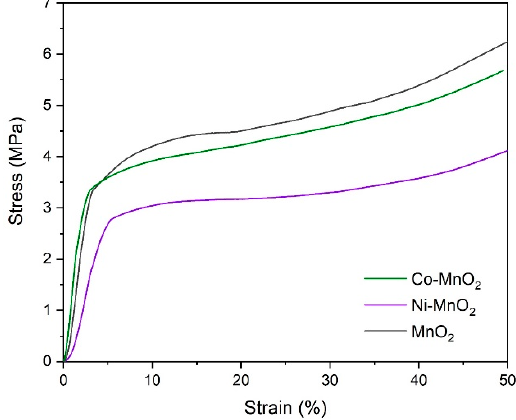
Figure 4. The mechanical properties of pristine MnO 2 , Ni-MnO 2 , and Co-MnO 2 samples.